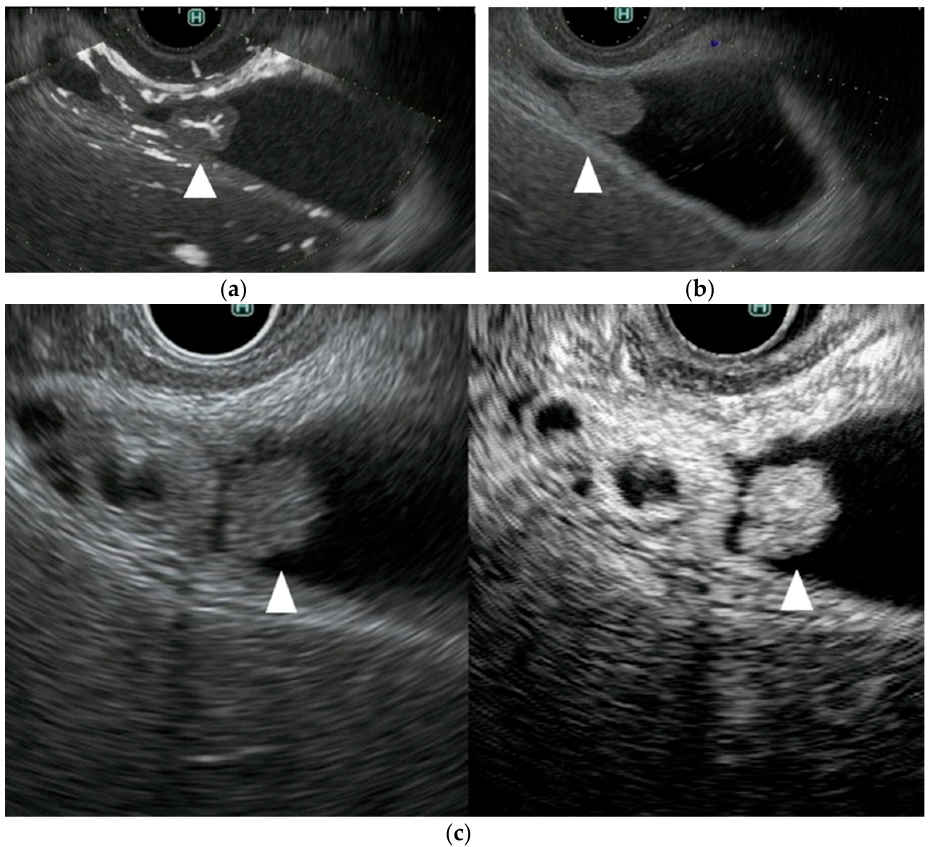
Figure 6. A representative case of a gallbladder cancer. ( a ) DFI endoscopic ultrasonography shows vascularity in the gallbladder lesion (arrow). ( b ) e-FLOW endoscopic ultrasonography shows no vascularity in the gallbladder lesion (arrow). ( c ) Contrast-enhanced endoscopic ultrasonography shows vascularity in the gallbladder lesion (arrow).